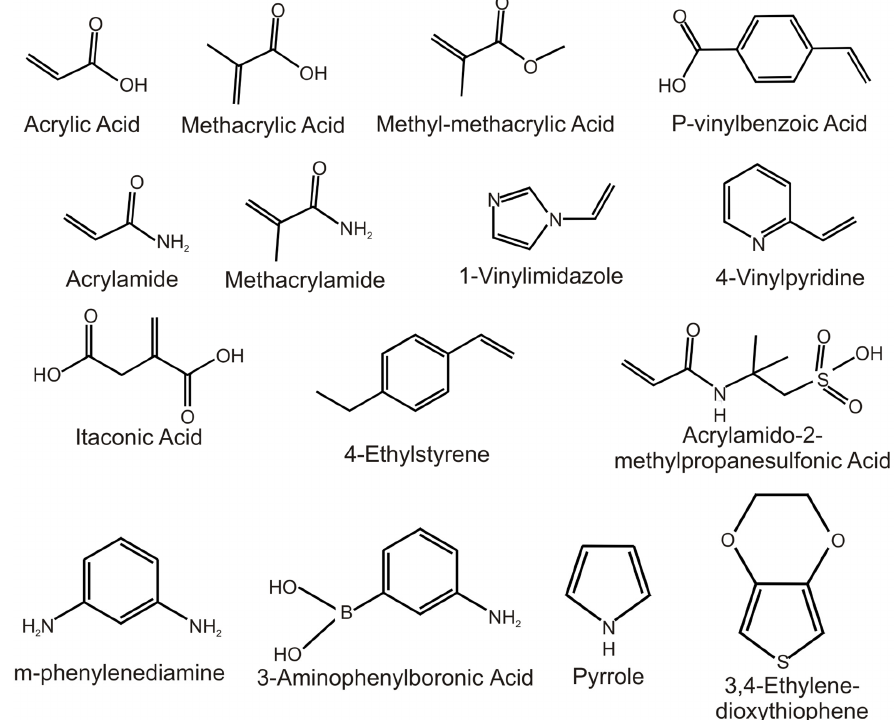
Figure 2. Structures of commonly used functional monomers for molecular imprinting.